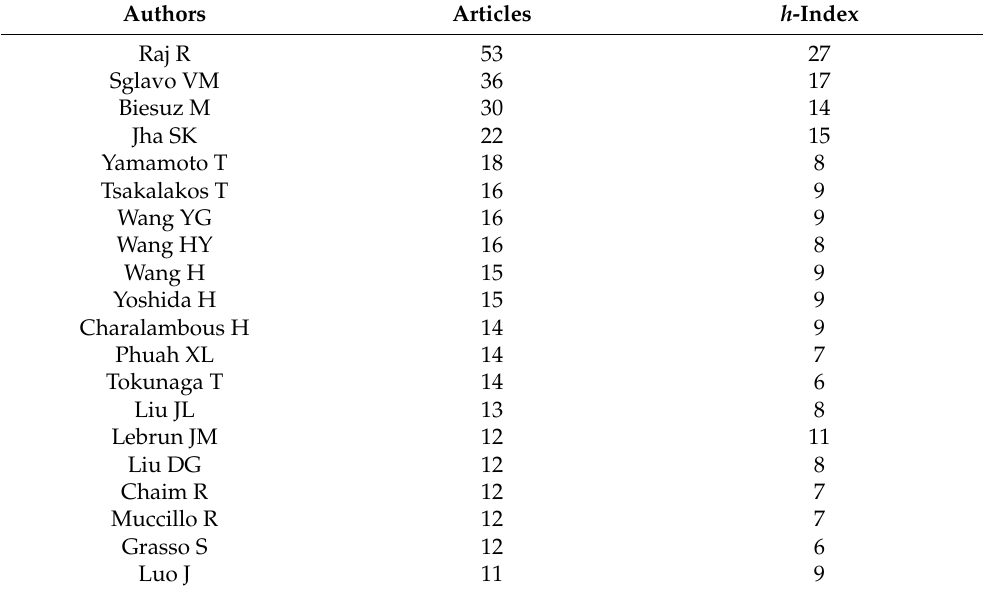
Table 2. Authors with the highest number of publications in the analyzed documents set along with their local h